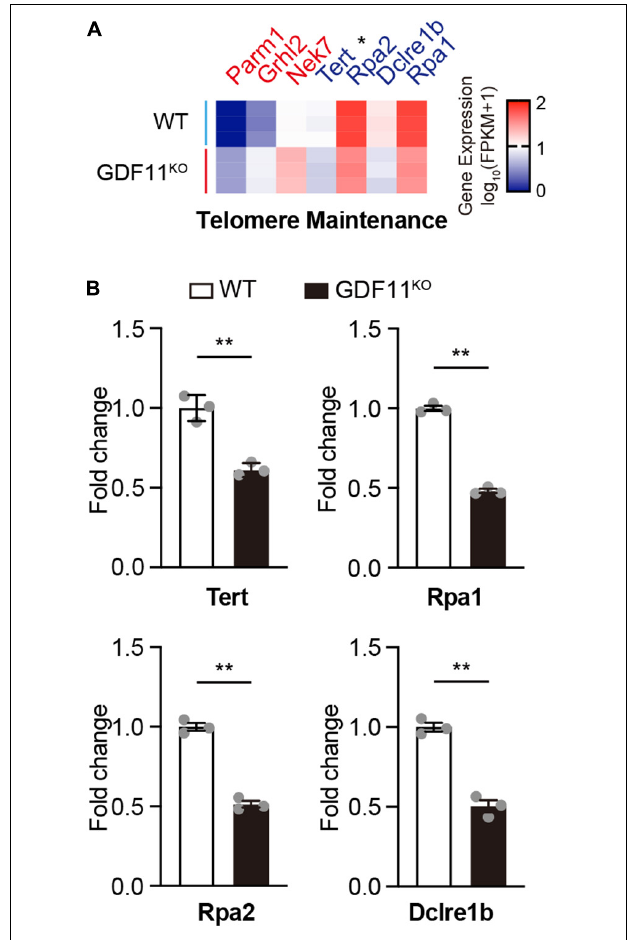
FIGURE 2 | Loss of GDF11 regulates telomere maintenance-related genes. Heatmap of upregulated (3, red) and downregulated (4, blue) (A) and bar graphs of 4 downregulated (B) telomere maintenance-related genes caused by deletion of GDF11 in single clone derived Neuro2a cells that were cultured for 65 days (two-tailed unpaired t -test, Tert: t = 7.262, df = 4, p = 0.0019; Rpa1: t = 24.58, df = 4, p < 0.0001; RPA2: t = 15.17, df = 4, p = 0.0001; DCLRE1b: t = 10.63, df = 4, p = 0.0004, n = 3 per group). Data are represented as mean ± SEM. * p < 0.05, ** p <